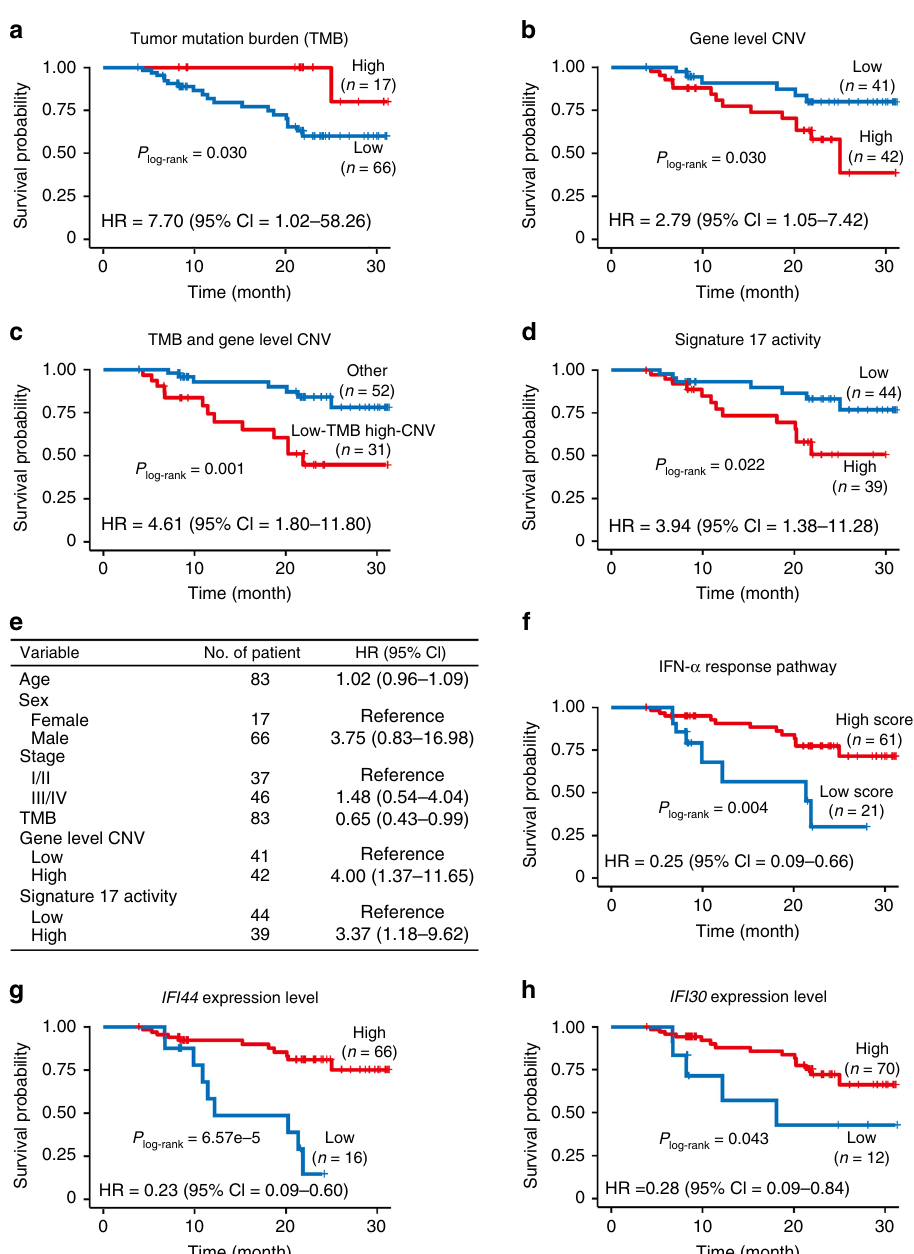
Fig. 5 Survival-associated genomic and transcriptomic features of ACGEJ. a – d Kaplan-Meier (KM) curves of patient survival according to TMB ( a ), gene level CNVs ( b ), TMB and gene level CNVs combined ( c ), and Signature 17 activities ( d ); P values derived from log-rank tests. e Multivariate Cox regression analysis of the effects of different genomic alterations on ACGEJ patient survival. f − h KM curves of patient survival according to the GSVA scores of IFN- α response pathway ( f ) and the expression levels of IFI44 ( g ) or IFI30 ( h ) gene; P values derived from log-rank tests. Also present with each KM plot are the hazard ratio (HR) and 95% con fi dence interval (CI) from multivariate Cox proportional hazard models including age, sex, tumor stage, TMB, and gene level CNVs as covariates wherever